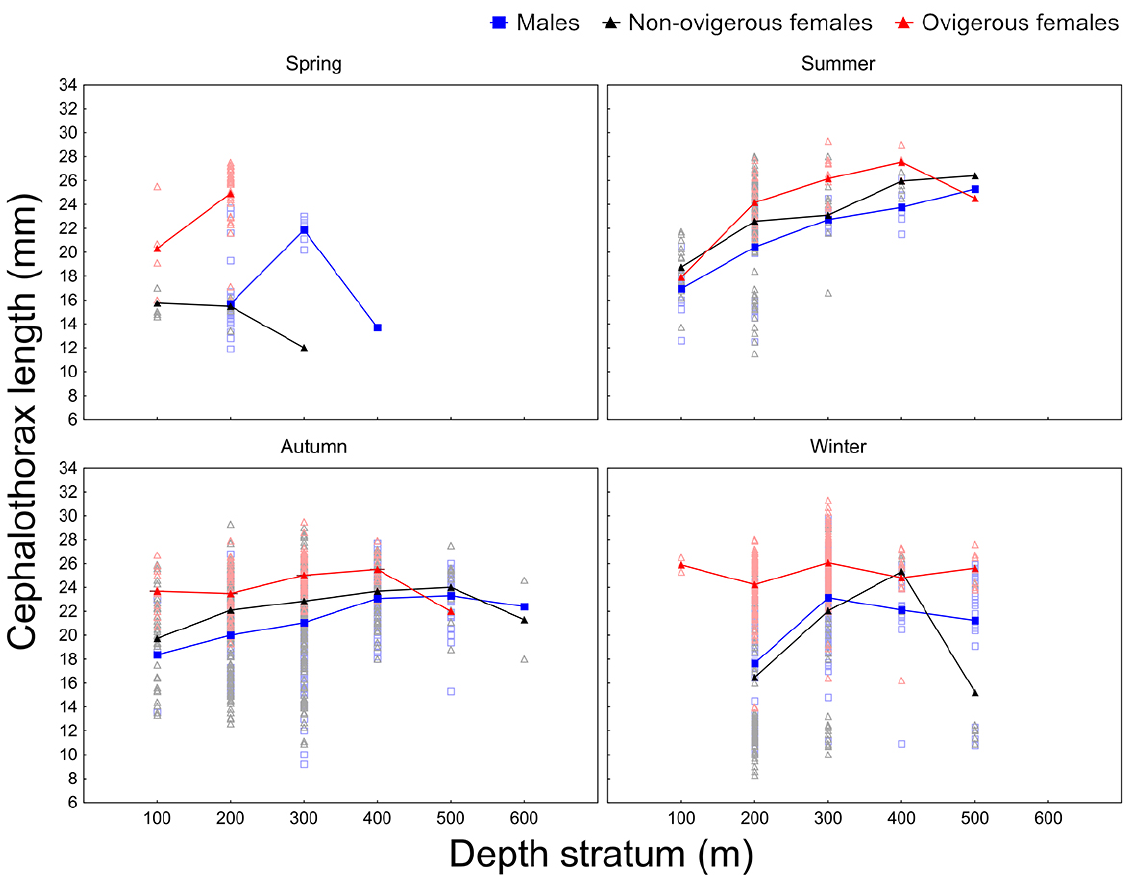
Figure 4. Seasonal predicted mean cephalothorax length (CL) by depth stratum for males, non-ovigerous and ovigerous females of Plesionika edwardsii in the Azorean region for the period 1999–2000. Light-colored symbols represent raw data. Detailed parameter estimates are in Tab.